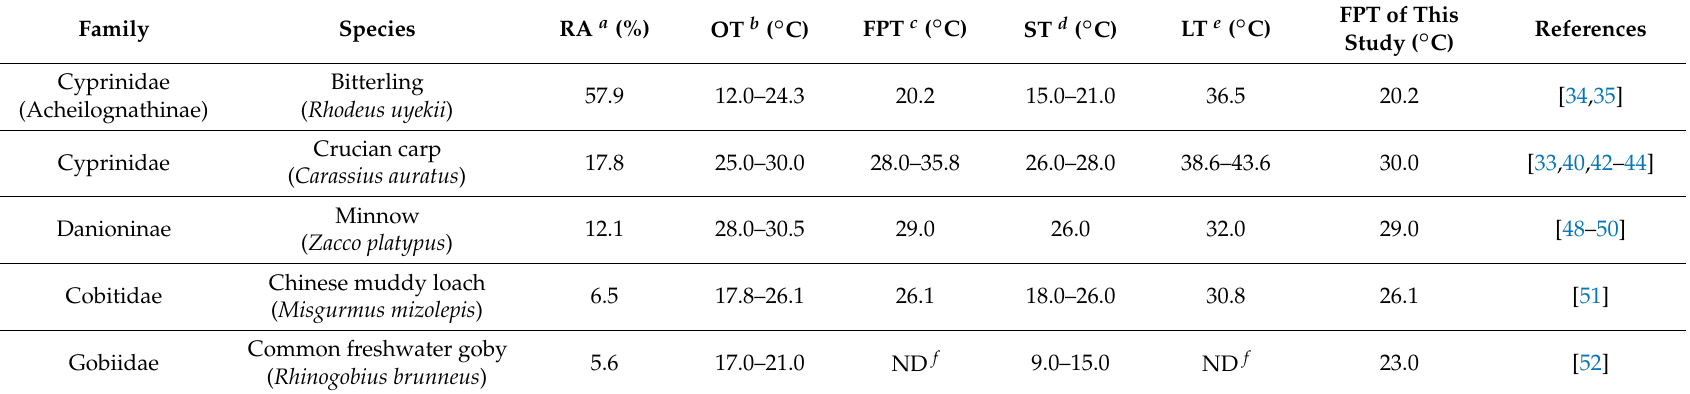
Table 3. Measurement data of relative abundance and characteristics for water temperature parameters of fish fauna in the